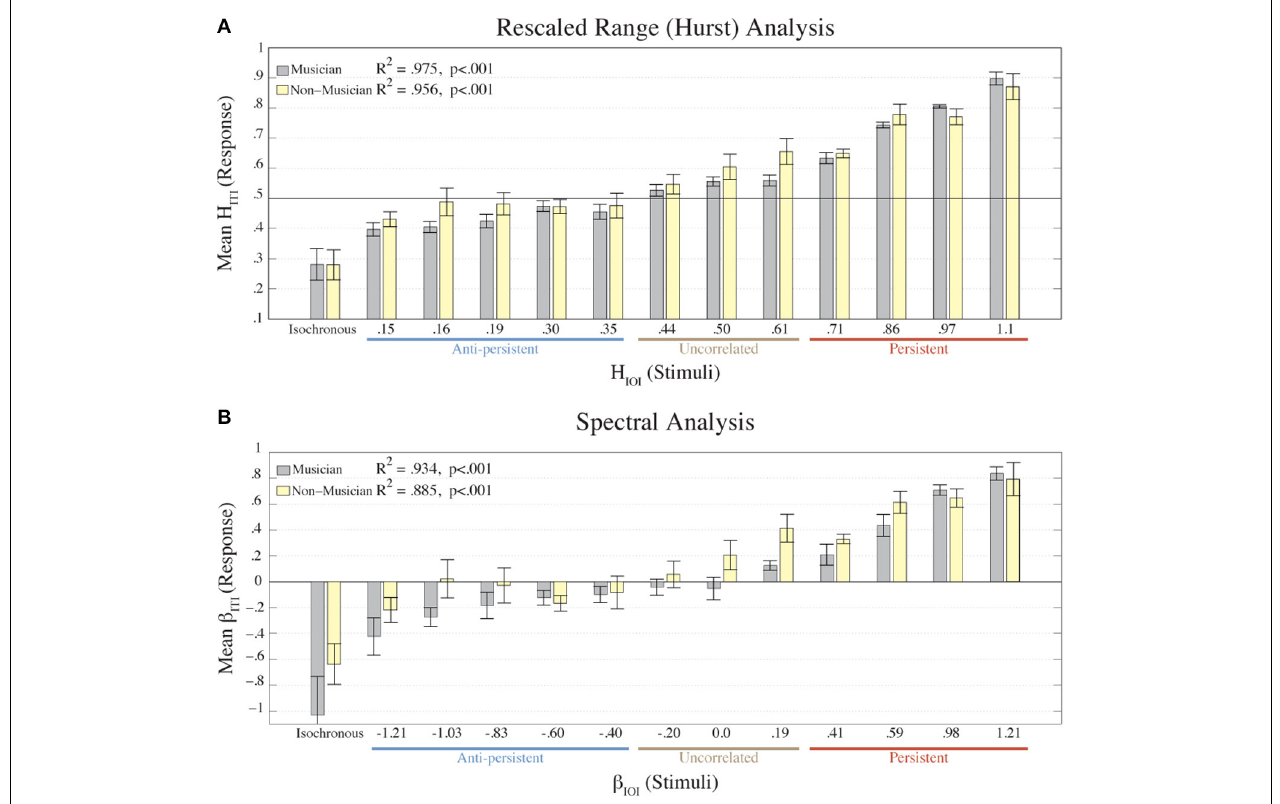
FIGURE 4 | The mean H ITI values of each group (musician, n = 8; non-musician n = 8) from the R/S analysis are plotted (A) for each condition ( H IOI ). The mean β ITI values of each group (musician, non-musician) from the Power Spectral Density analysis are plotted (B) for each condition ( β IOI ). Error bars represent the standard error of the mean.